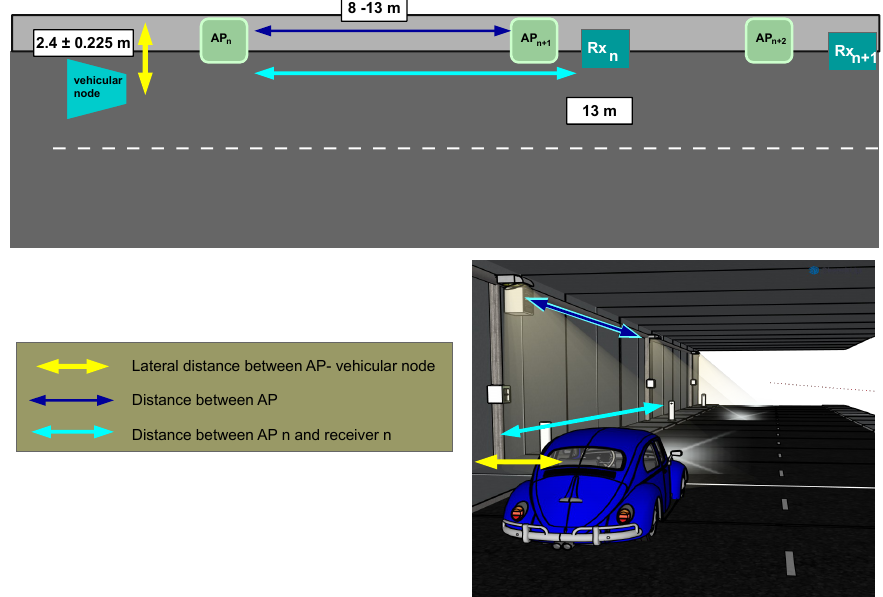
Figure 13. Scenario 1: Graphical representation of the VLC network with one vehicular